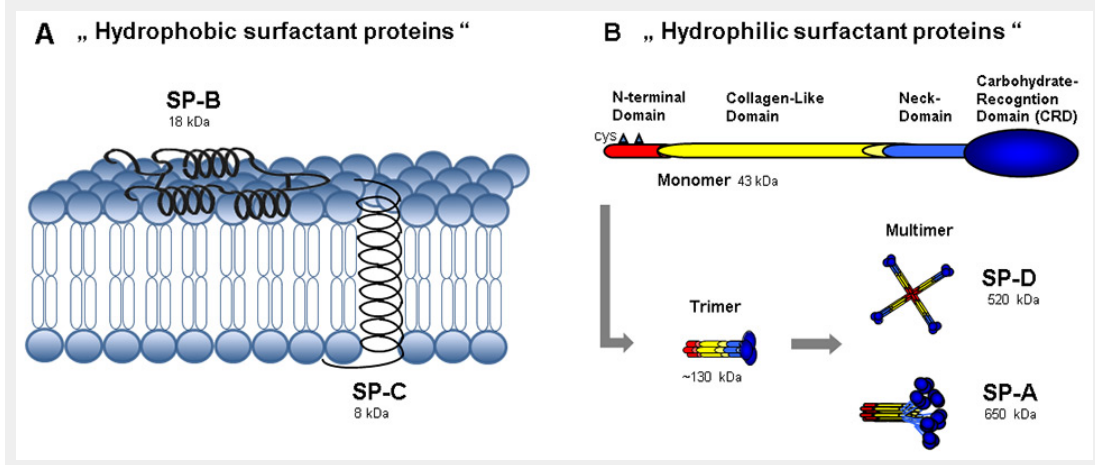
(A) The hydrophobic surfactant proteins B and C are small proteins with α-helices. SP-B is arranged in monolayers or bilayers on the surface of surfactant lipids. Together with SP-C, which is integrated into the phospholipid membrane, they facilitate the spreading and adsorption of lipids into the phospholipid membrane and enhance its stability. Thereby, they greatly contribute to the reduction of surface tension in the alveoli. (B) The hydrophilic surfactant proteins SP-A and SP-D are large multimeric proteins which are assembled from monomers with cysteinyl (cys) residues in the N-terminal domain. These monomers have a characteristic carbohydrate recognition domain in their C-terminal ending, with distinctive binding affinities to glycosylated structures. Trimers are established by covalent disulphide bridging of three monomers, which subsequently assemble into higher multimeric